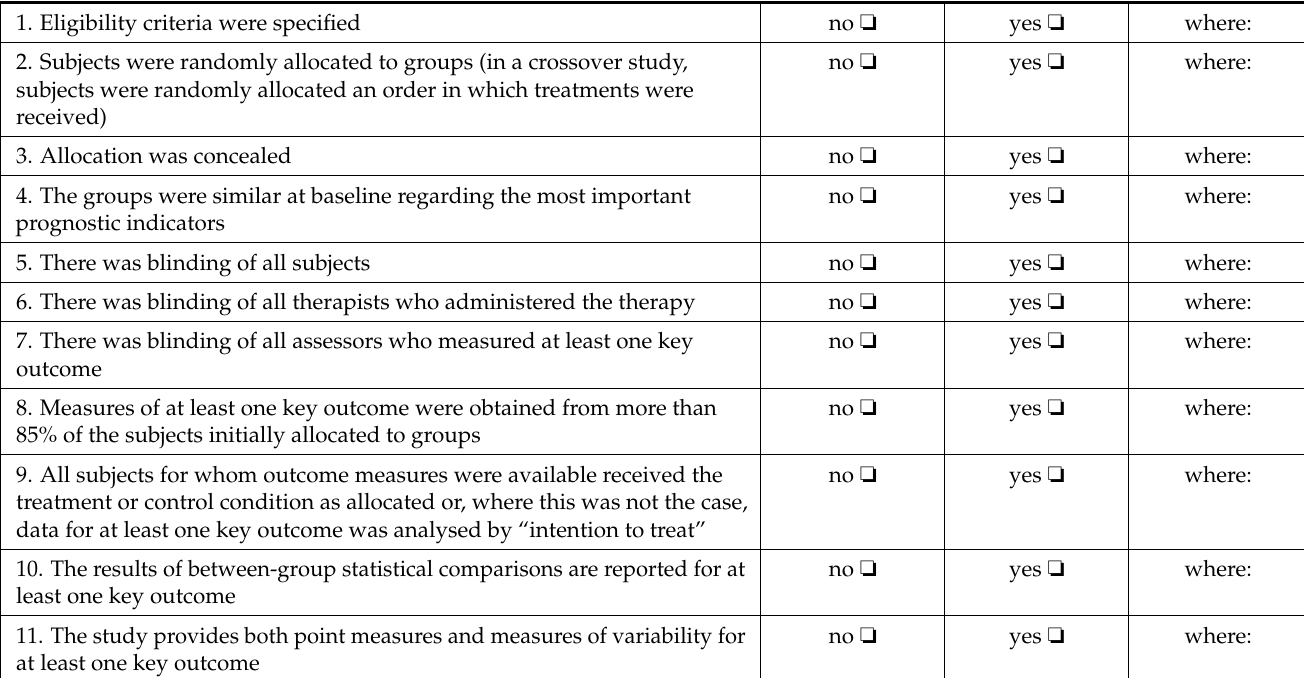
Table 2. PEDro Scale.